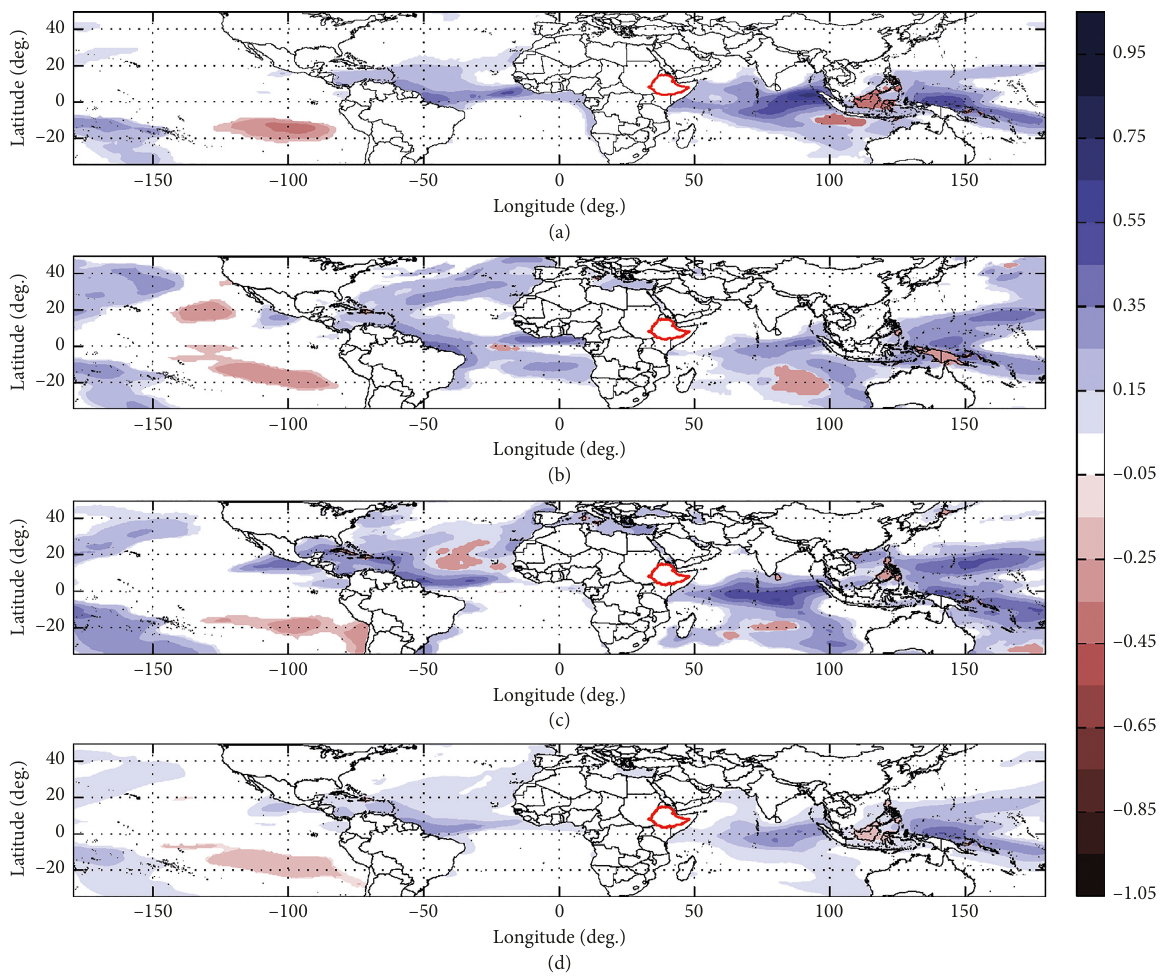
Figure 6: Rainfall and SST (averaged over 50 S–50 N, 200–200 E) correlations: (a) correlation coefficient of the Bega (ONDJ) rainfall trend and SST raw; (b) correlation coefficient of the Belg (FMAM) rainfall trend and SST raw; (c) correlation coefficient of the Kiremt (JJAS) rainfall trend and SST raw; (d) correlation coefficient of the annual rainfall trend and SST